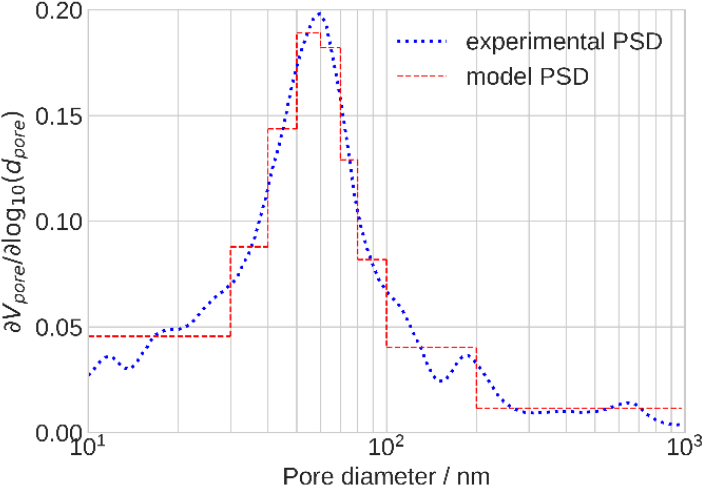
Figure 3. Experimental [32] (dotted line) and approximate model (dashed line) pore size distributions in the cathode catalyst layer.